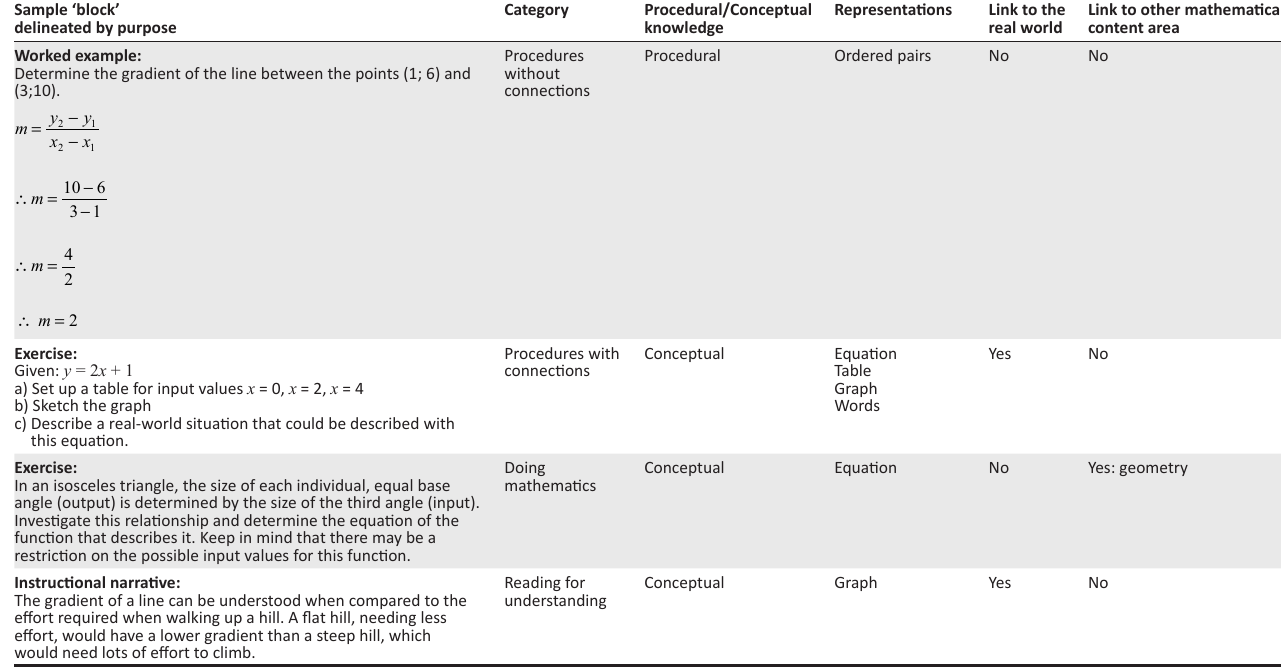
TABLE 2: Examples of the types of content ‘blocks’ found in Classroom Mathematics Grade 9 and Elemente der Mathematik 3 , and how these were coded. Sample ‘block’ delineated by purpose